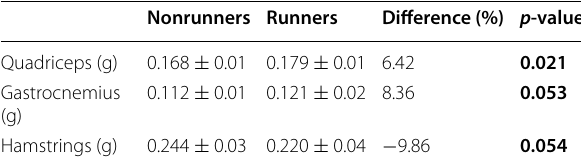
Table 3 Least square means differences in primary muscles acting on the knee between B6 runners and